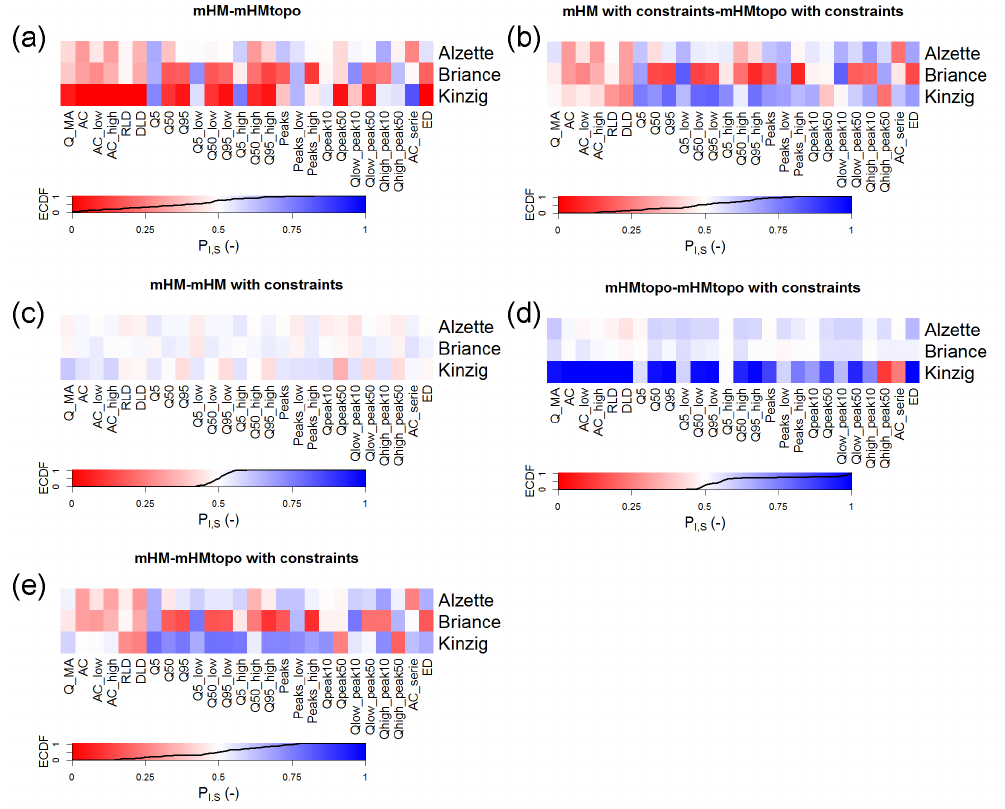
Figure 14. Probabilities of improvements P I , S between (a) mHM and mHMtopo without constraints and (b) with constraints, (c) mHM with and without constraints, (d) mHMtopo with and without constraints and (e) the base case mHM with the constrained mHMtopo case, all after the transfer of global parameters to the three catchments. The colours are linearly related to the probability of improvement between 0 (dark red; e.g. the probability of mHMtopo outperforming mHM is 0), 0.5 (white; i.e. models are statistically equivalent) and 1 (dark blue; e.g. the probability of mHMtopo outperforming mHM is 1). An empirical cumulative distribution function (ECDF) based on all probabilities of improvement has been added to assess the distribution of these